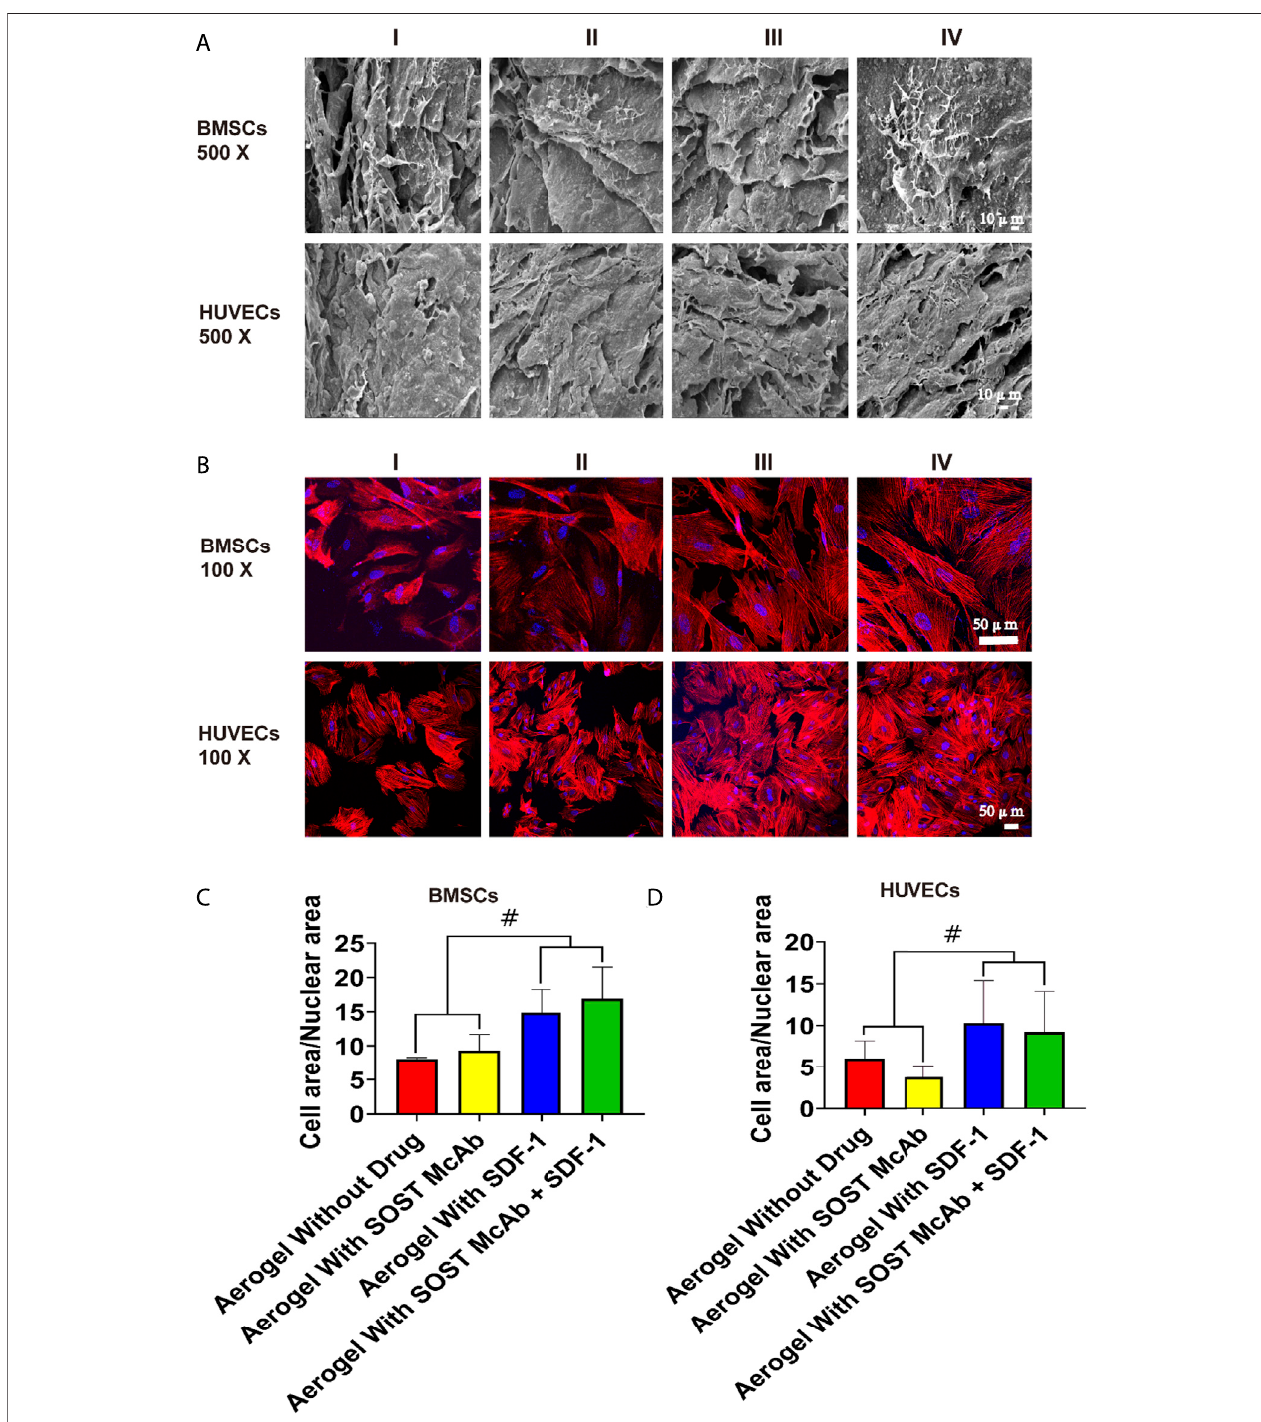
FIGURE4| ThebiocompatibilityoftheNCF-Col-NHAaerogelscaffoldwithBMSCsandHUVECs invitro . (A) Undertheelectronmicroscope,BMSCsandHUVECs can adhere to the surface of aerogel scaffolds loaded with different drugs (B – D) . Observation on the morphology of cells on the surface of NCF-Col-NHA aerogel scaffolds. The results of iFluor555 labeled phalloidine and diaminphenyl indoles stain and cell area/nuclear area calculation showed that SDF-1 was bene fi cial to the adhesionandgrowthofBMSCsandHUVECsonthesurfaceofthescaffolds.GroupI,aerogelscaffoldwithoutloadingdrugs;GroupII,aerogelscaffoldloadedwith SOST McAb; Group III, aerogel scaffold loaded with SDF-1; Group IV, aerogel scaffold loaded with SOST McAb + SDF-1. BMSCs, bone marrow mesenchymal stem cells; HUVECs, Human umbilical vein endothelial cells. #, p ＜ 0.05.